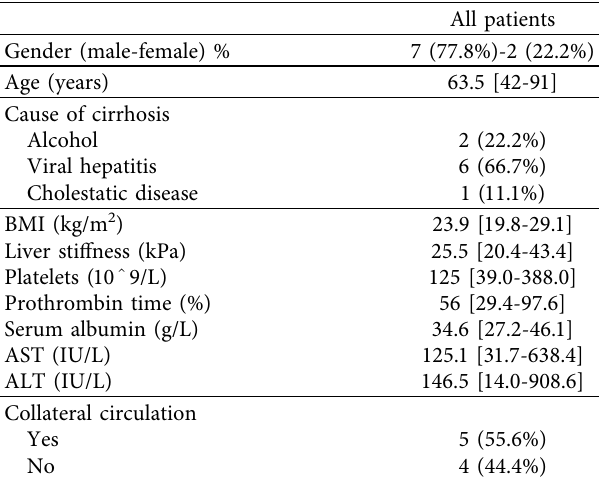
Table 1: Main characteristics of the patients.